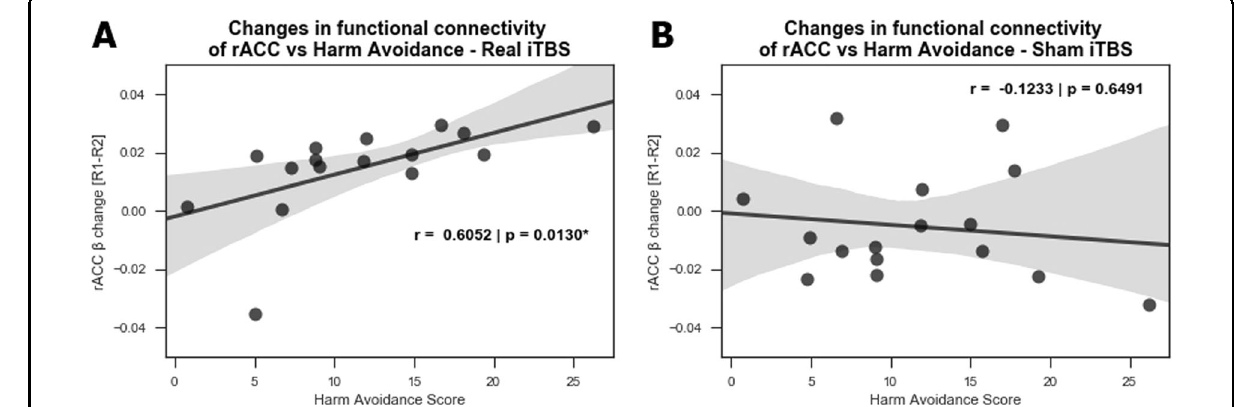
Fig. 5 Correlation to harm avoidance scores. Correlation between the HA score and the changes observed in rACC functional connectivity during R2 rsfMRI compared to R1 rsfMRI for ( a ) real and ( b ) sham conditions. A signi fi cant positive correlation is observed after real stimulation